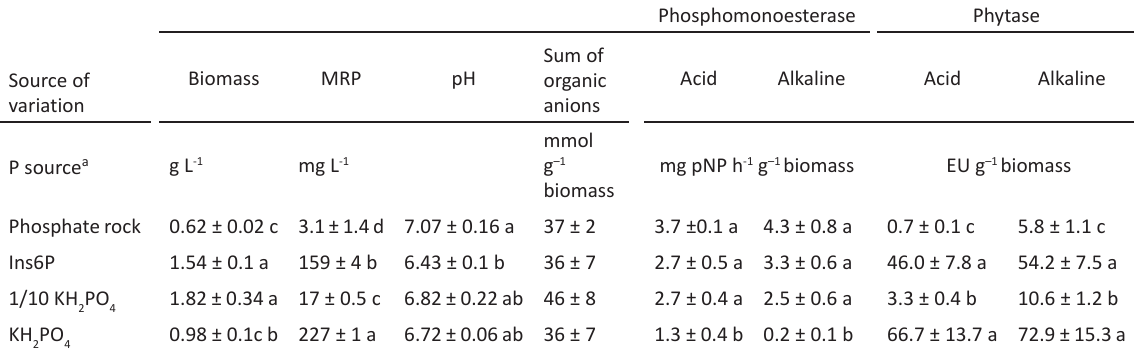
Table 1. Effect of various P sources on Trichoderma asperellum T34 biomass, molybdate reactive P (MRP) concentration and pH, organic anions and enzyme production in liquid cultures of the fungus (Czapek media